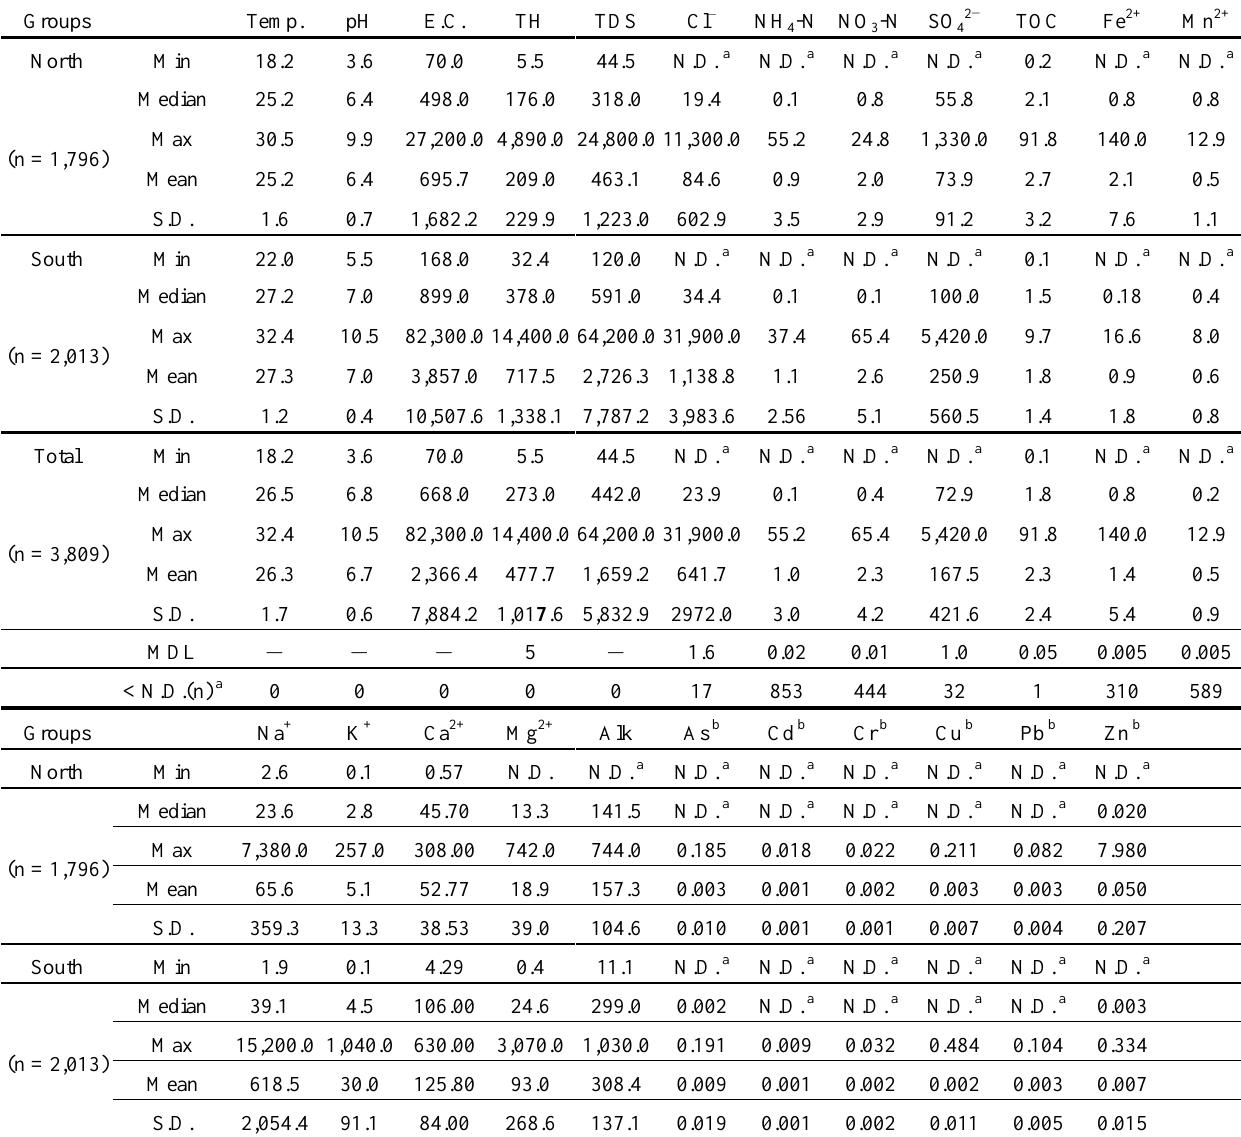
Table 1. Summary statistics for hydrochemical data in Taiwan (unit: EC as cm/S  , others as